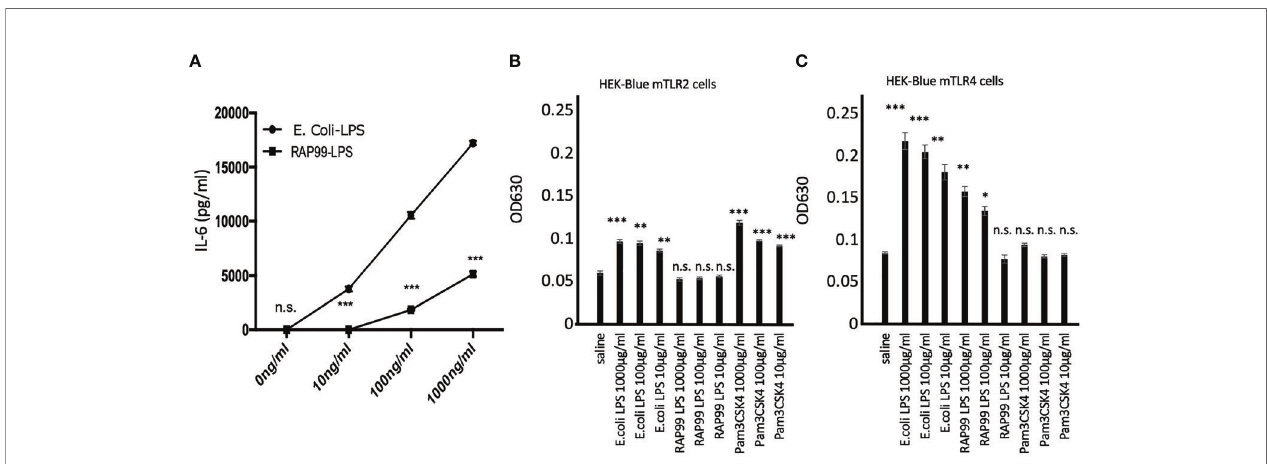
FIGURE 1 | RAP99-LPS stimulates TLR4 but not TLR2 in vitro . (A) IL-6 concentration in the culture supernatant by ELISA. BC1 cells were treated with E.coli -LPS or RAP99-LPS for 24 h prior to the analysis. (B) OD630 was analyzed 6 h after treating HEK-Blue ™ mTLR2 and (C) HEK-Blue ™ mTLR4 cells with E. coli -LPS or RAP99-LPS. Mean scores ± SD are shown. *p < 0.05, **p < 0.01, ***p < 0.005; n.s., not signi fi cant; Student ’ s t tests. (Representative data are